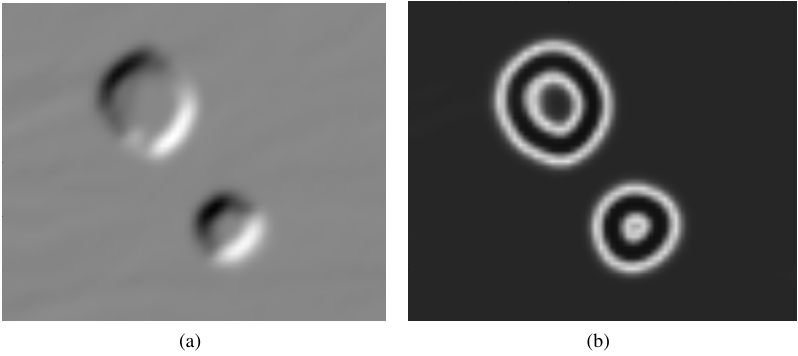
Figure 2. a) Shaded relief of two sinkholes; b) Edge map used for the level-set evolution. Note there are multiple collapses within the sinkhole.